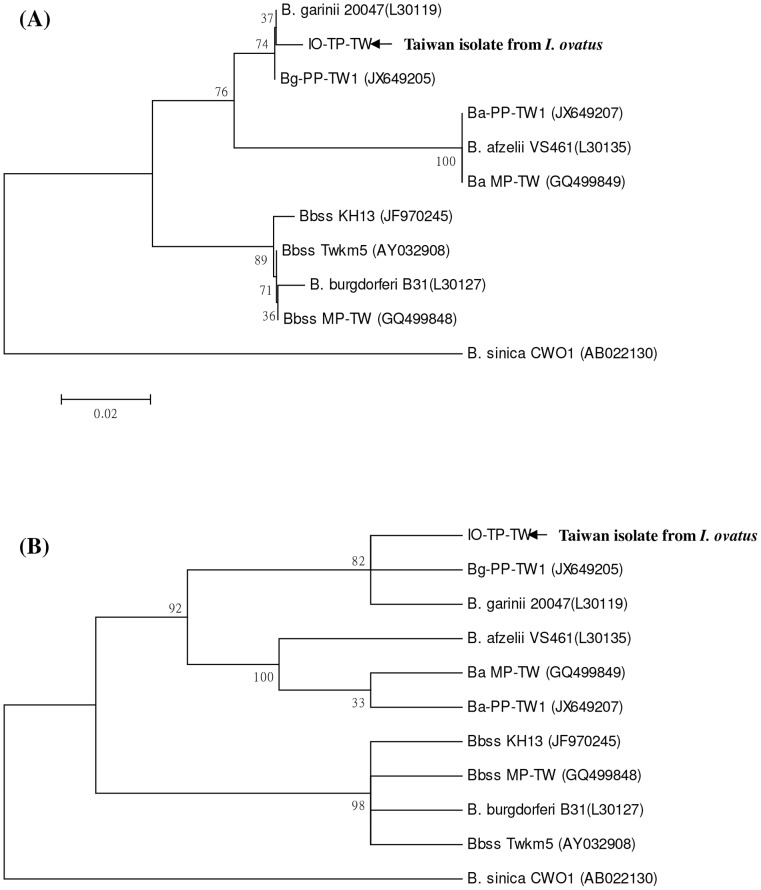
Phylogenetic relationships based on the 5S (rrf) –23S (rrl) rRNA gene sequences of Borrelia spirochetes isolated from I. ovatus tick (strain IO-TP-TW) and other biological sources (i.e., human, tick and rodent) in Taiwan.The trees were constructed and analyzed by (A) neighbour-joining and (B) maximum parsimony methods using 1000 bootstraps replicates. Numbers at the nodes indicate the percentages of reliability of each branch of the tree. Branch lengths are drawn proportional to the estimated sequence divergence.